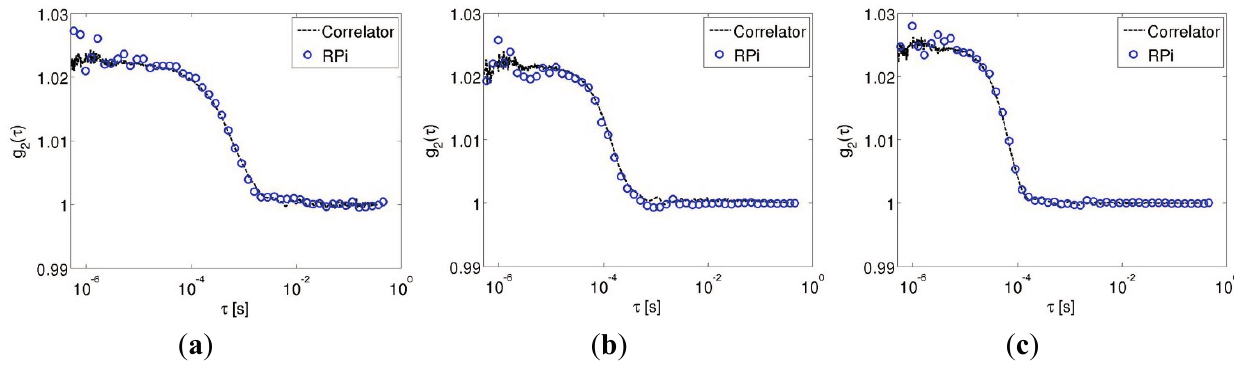
Figure 2. Autocorrelation traces acquired directly from the hardware correlator (line) and numerically computed from the acquired signal on the Raspberry Pi (symbols) for three different flow rates: ( a ) 0 µL/s; ( b ) 56 µL/s; ( c ) 140